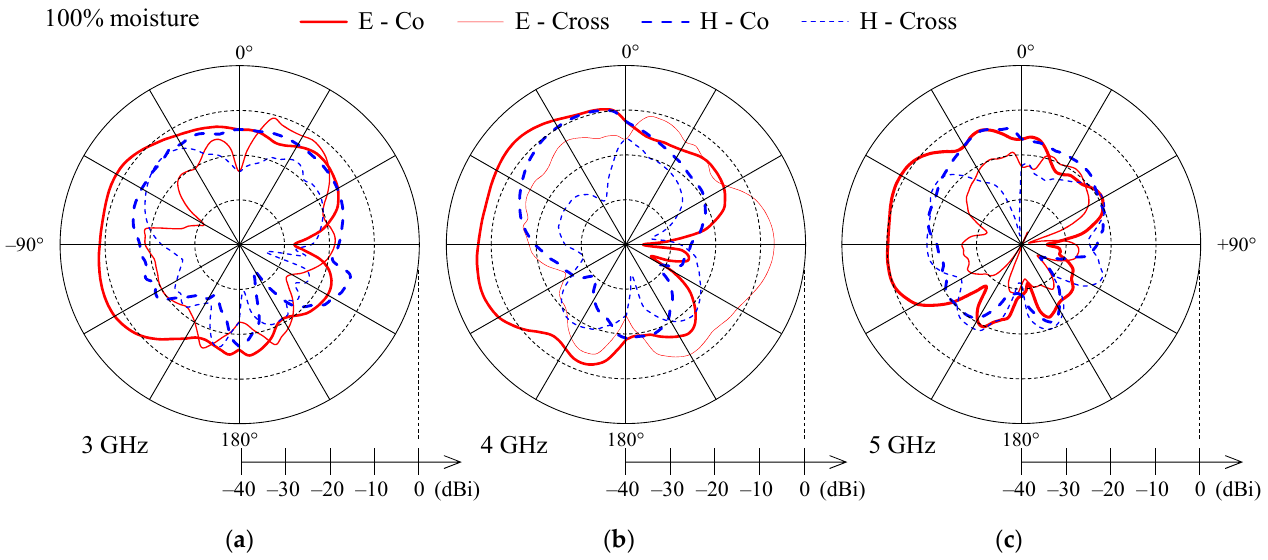
Figure 12. Measured co-polarization (thick line) and cross-polarization (thin line) gain patterns in E-plane (solid) and H-plane (dashed) for the wideband textile monopole with 100% moisture content at ( a ) 3 GHz, ( b ) 4 GHz, and ( c ) 5 GHz.